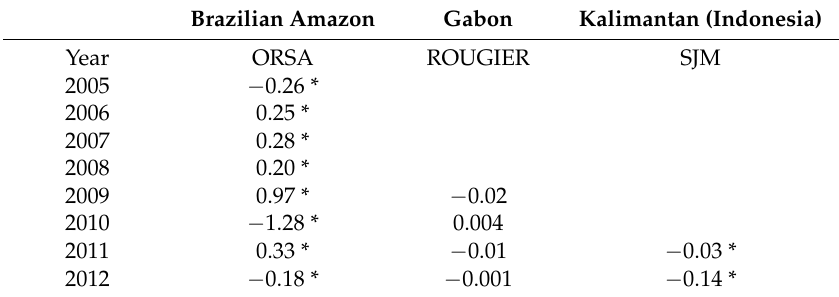
Table 4. Estimated effects of certification on percent tree cover loss by calendar year for three certified